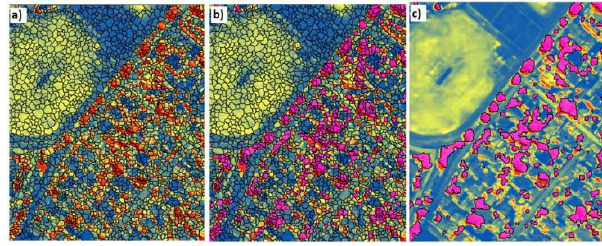
Figure 7. Refinement of the classification result from CNN a) Segmentation of local maxima heatmap result b) Segments with local maxima value >0.3, and NDVI value >0.1 and CHM value >2 to trees class which is represented by pink colour c) Merged trees class.